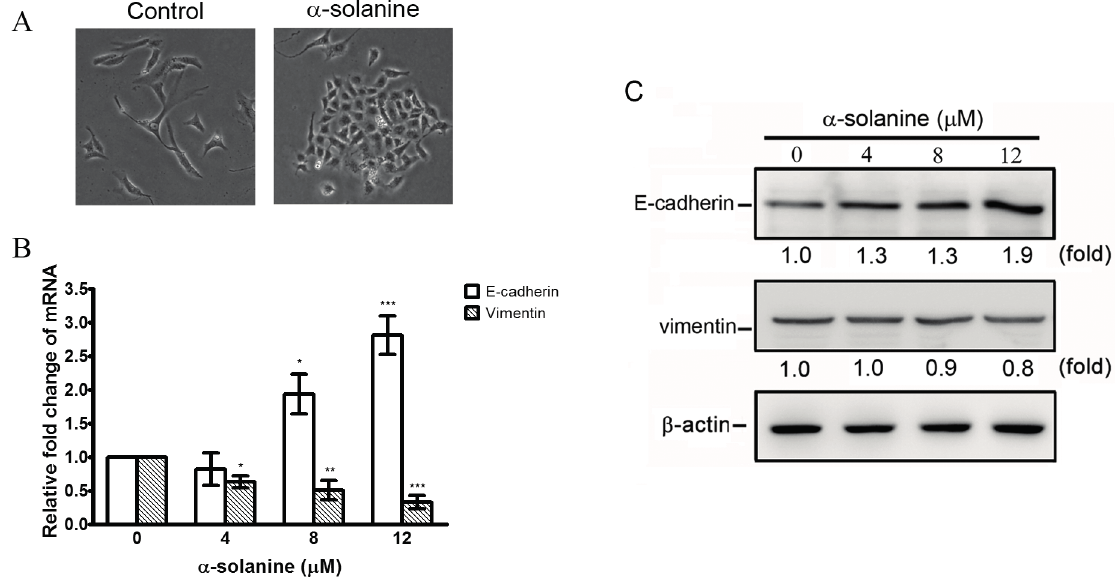
Figure 4. Regulation of epithelial-mesenchymal transition by α -solanine in PC-3 cell. ( A ) Cells were treated with 12 μ M of α -solanine for 48 h and cell morphology were photographed (100× magnification). Cells were treated with various concentrations of α -solanine for 24 h and the expressions of E-cadherin and vimentin mRNA ( B ) and protein ( C ) were analyzed by quantitative real-time PCR and Western blotting, respectively. Data are expressed as mean ± S.D. of three independent experiments. * p < 0.05, ** p < 0.01, *** p < 0.001 compared with the untreated